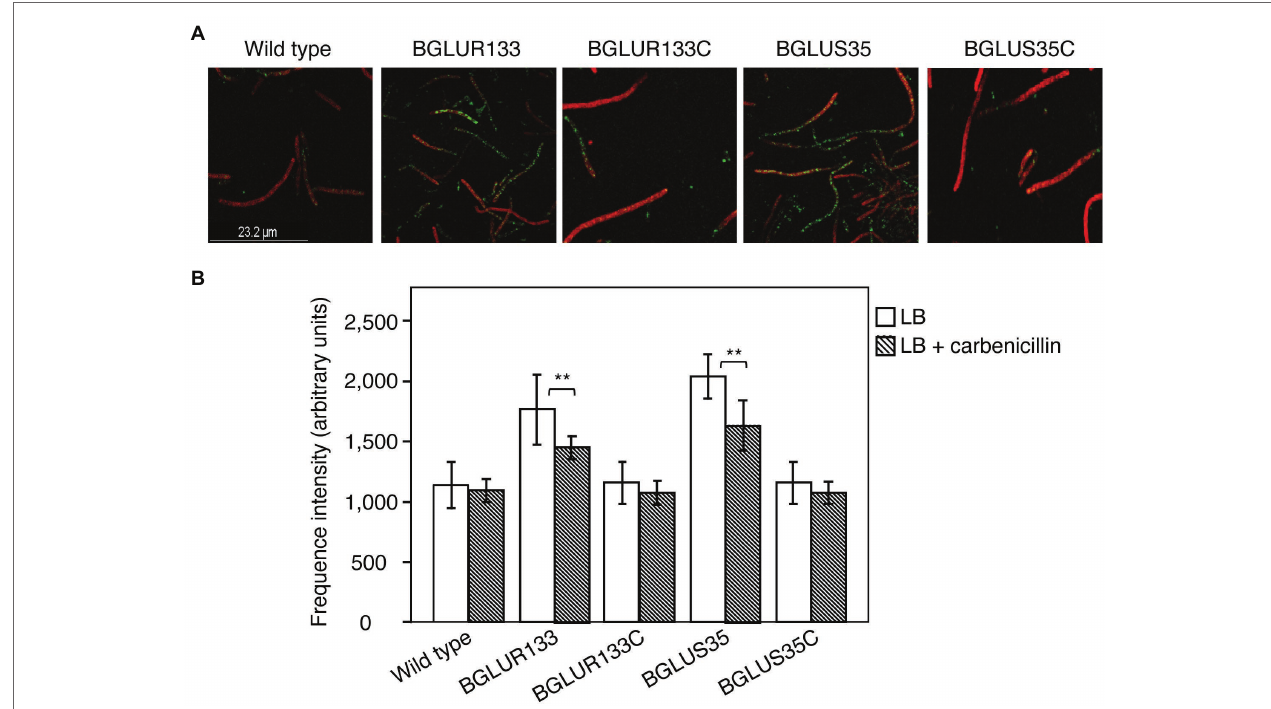
FIGURE 6 | Characterization of PBPs in the indicated B. glumae strains. (A) Uninhibited PBPs cultured overnight in LB containing 50 μ g/ml carbenicillin were stained with Bocillin FL and then subjected to a cell membrane dye (FM-4-64). Green fluorescence spots indicate uninhibited PBPs. (B) Quantification of PBP fluorescence intensity using Bocillin FL. Fluorescence images and intensity values were obtained at excitation/emission wavelengths of 488/500–535 and 515/621– 678 nm for Bocillin FL and FM-6-64, respectively. Data are mean ± SE of triplicate experiments. Statistical analysis was performed using one-way ANOVA, followed by Tukey’s test for multiple comparisons (** p < 0.05; F 4,20 = 31.455, 31.506, p = 0.00 for LB and LB with carbenicillin,